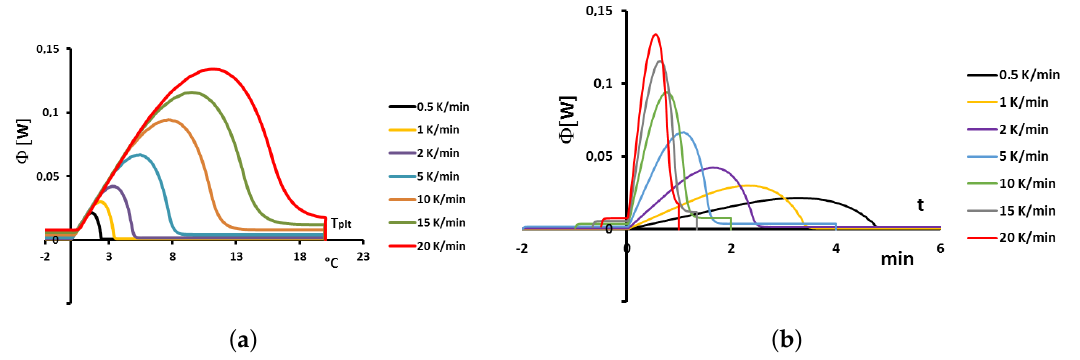
Figure 9. DSC curves at various heating rates for a pure substance. ( a ) Thermogram in function of T plt ; ( b ) Thermogram in function of t